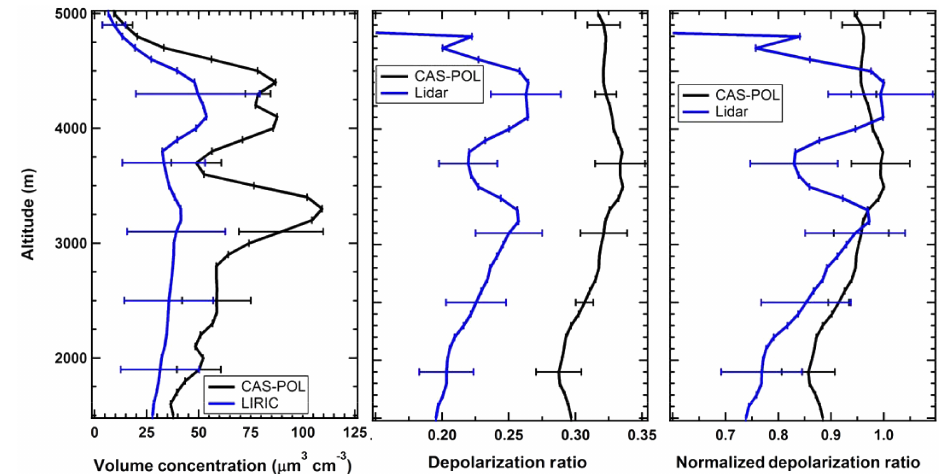
Figure 6. (a) 30min averaged volume concentrations retrieved with LIRIC (blue line) centered at 10:30UTC and the combined PCASP- 100X and CAS-POL concentrations (black line) retrieved during the flight ascent on the 27 June 2011. The blue horizontal bars are the estimated uncertainty in the LIRIC values and the black horizontal bars are the standard deviation about the average aircraft values. (b) De- polarization ratio retrieved from the CAS-POL measurements (black line) and δ P retrieved from the lidar data (blue line) between 10:30 532nm and 11:00UTC Horizontal bars show the estimated uncertainties from the lidar (blue) and the standard deviation about the average CAS-POL values (black). (c) Depolarization ratios normalized to the maximum values derived from the lidar (blue) and CAS-POL